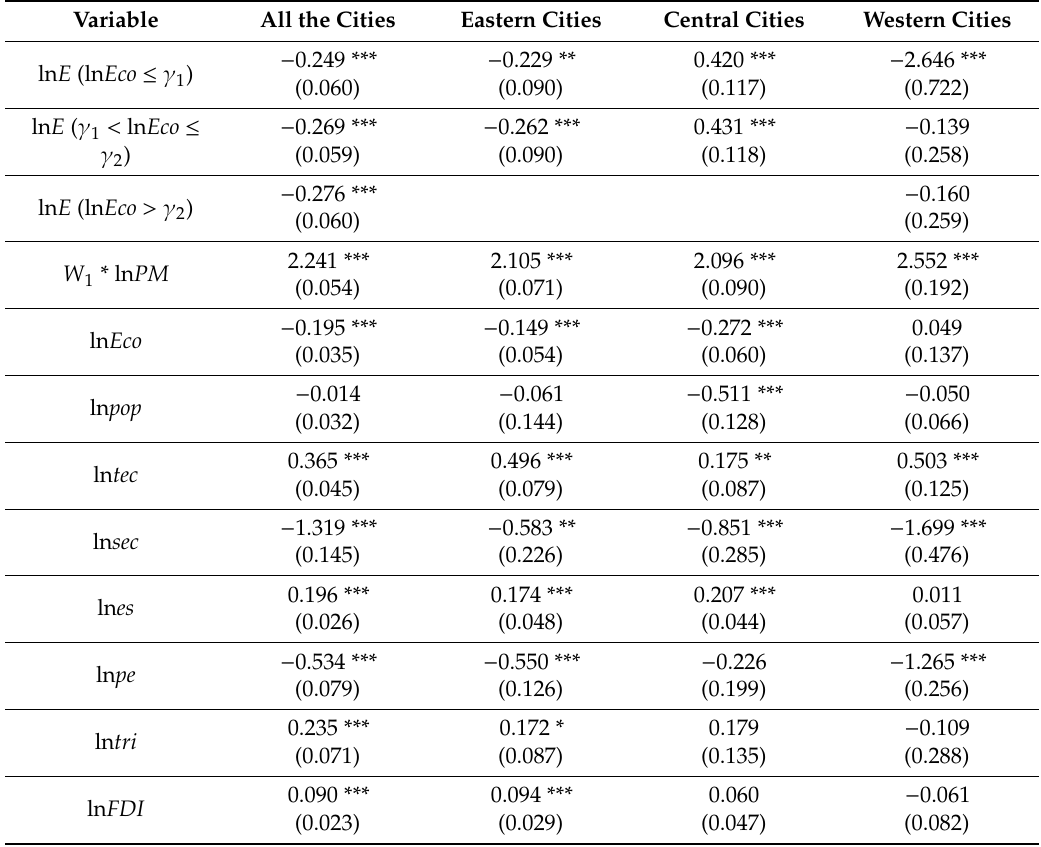
Table 8. Parameter estimation results of threshold regression